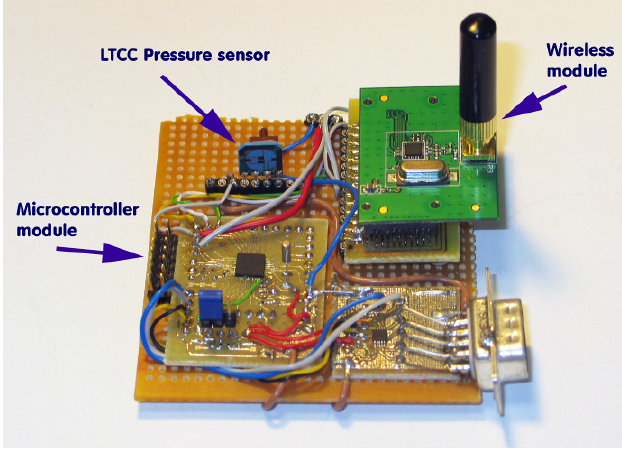
9. Low-power wireless pressure-monitoring system with a piezoresistive LTCC-based pressure sensor.